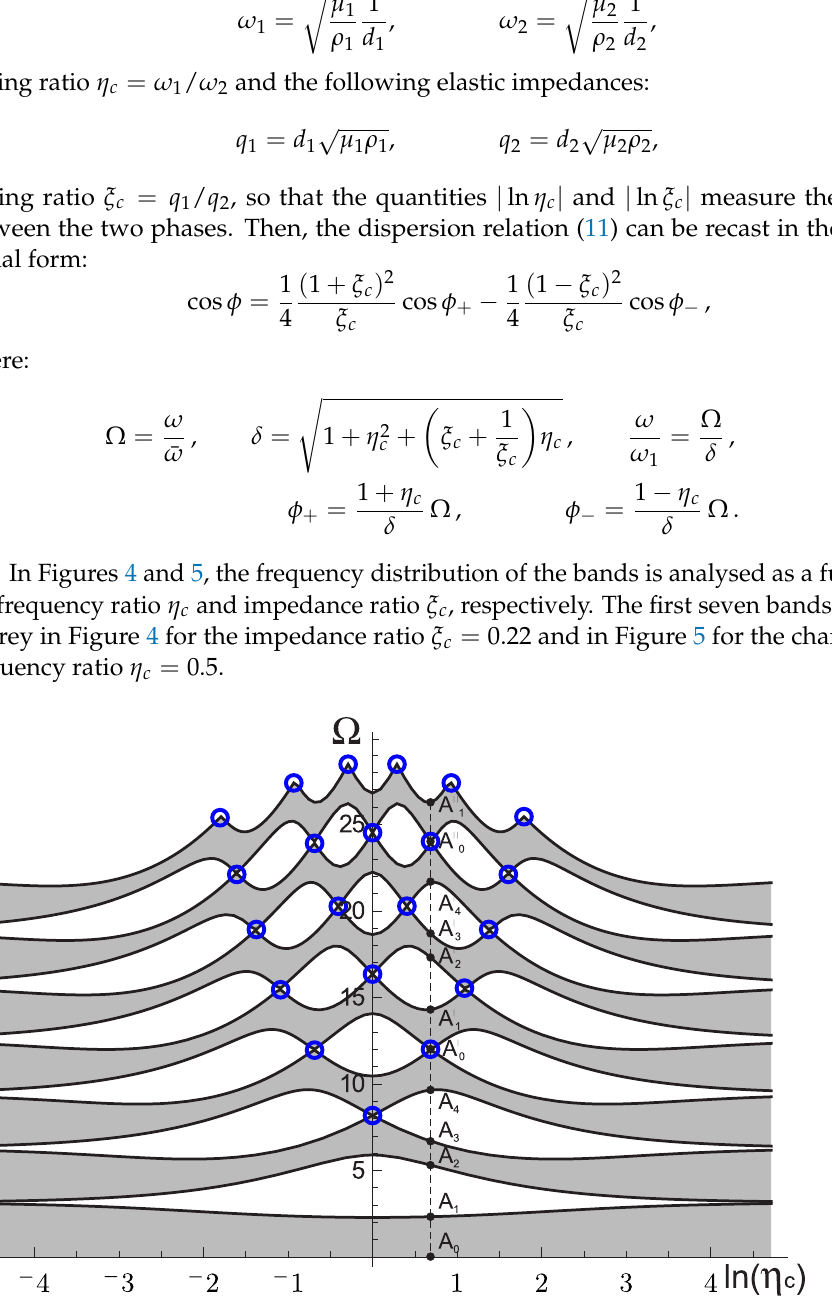
Figure 4. Continuous laminate. Band distribution as a function of the characteristic frequency ratio η c = ω 1 / ω 2 . Normalised frequency Ω = ω / ¯ ω is given for the impedance ratio ξ c = q 1 / q 2 = 0.22. Filled areas indicate propagating bands. The dashed line corresponds to the case analysed in Figure 3. Blue circles highlight periodicity